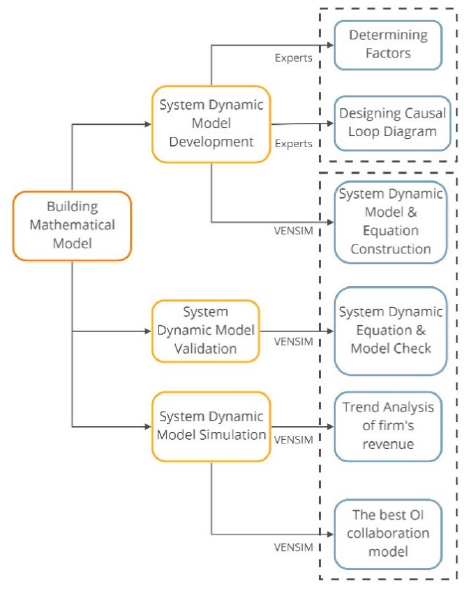
Figure 2. Building mathematical model for system dynamics.